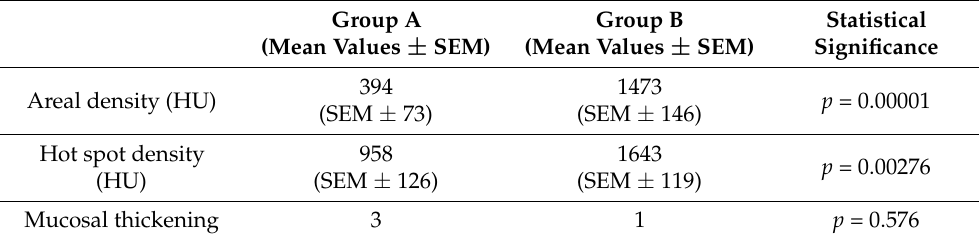
Table 2. Radiological examination by HRCT of the temporal bone, comparing group A and group B. Group A Group B Statistical Significance (Mean Values ± SEM) (Mean Values ± SEM) 394 1473 p = 0.00001 Areal density (HU) (SEM ± 73) (SEM ± 146) Hot spot density 958 1643 p = 0.00276 (HU) (SEM ± 126) (SEM ± 119) p = 0.576